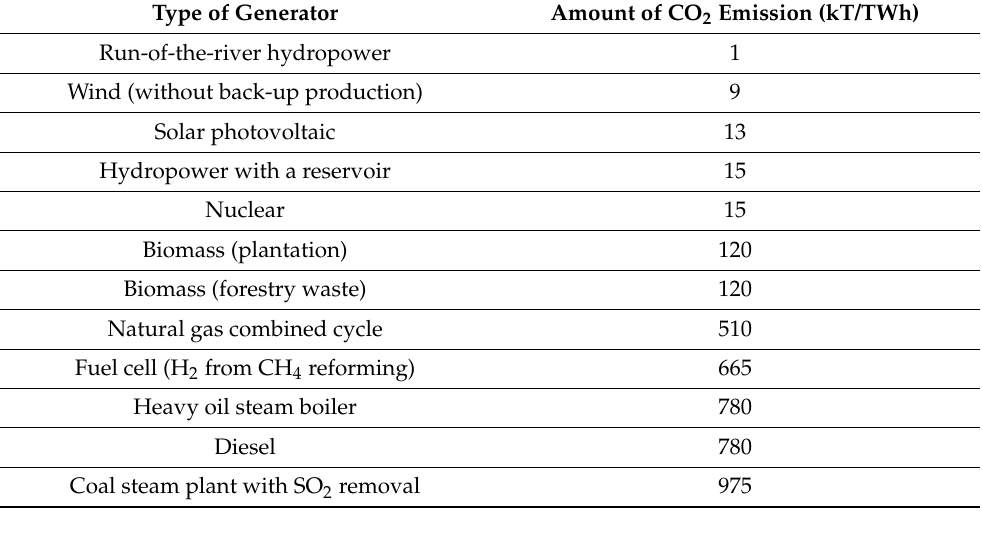
Table 2. CO 2 emission amount of generator type [33,34]. (Reprint with permission [33,34]; September 2008 and 14 June 2012, ISO and IEC).